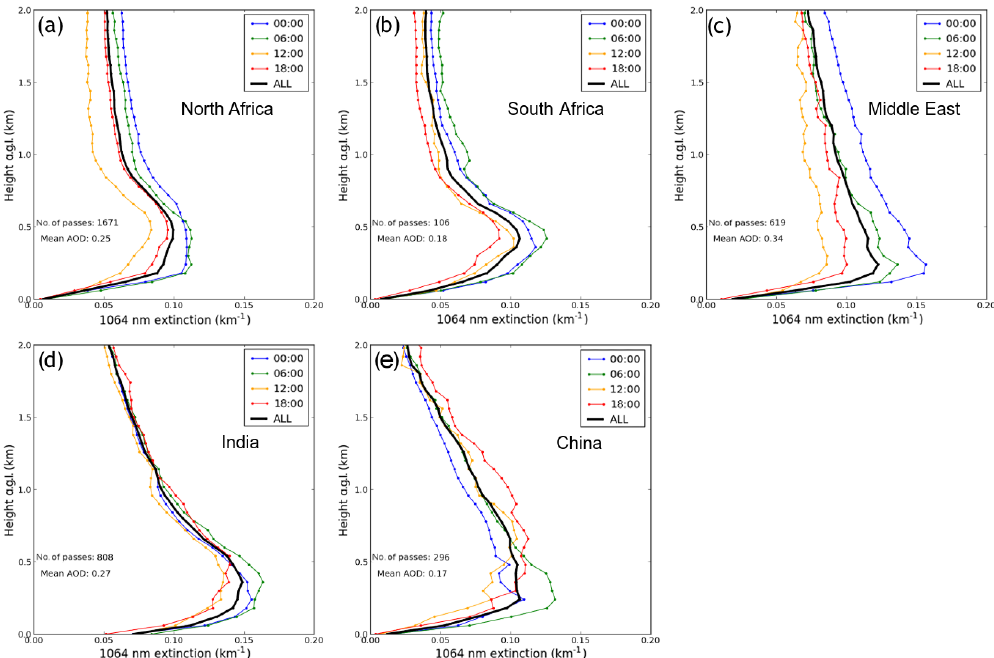
Figure 13. JJASON 6h average (00:00, 06:00, 12:00 and 18:00LT) vertical profiles of CATS 1064nm for locations shown in Fig. 6b; (a) north Africa, (b) south Africa, (c) the Middle East, (d) India and (e) northeast